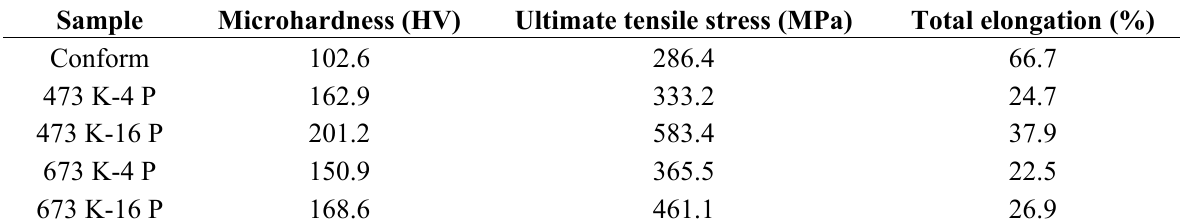
Table 1. Microhardness and tensile properties of the samples ECAPed at 473 K or 673 K.